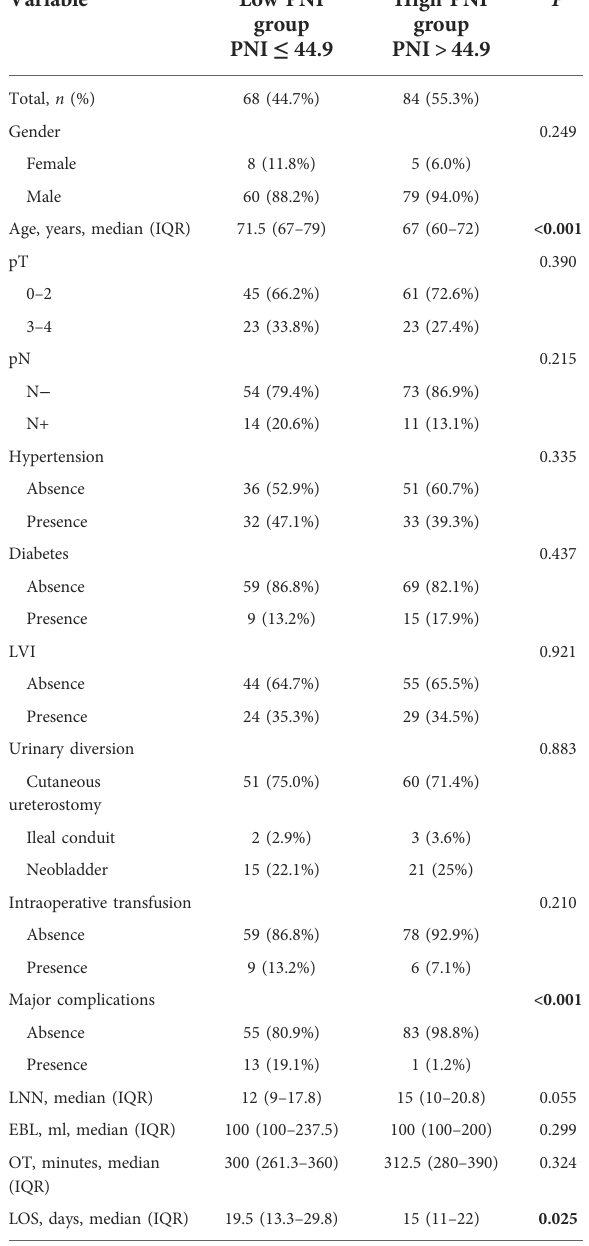
TABLE 5 Association of PNI with pathological stage and perioperative outcome.